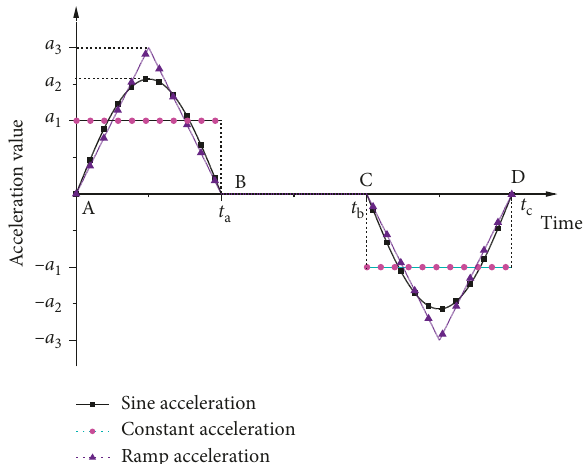
Figure 2: The motion acceleration curves of a